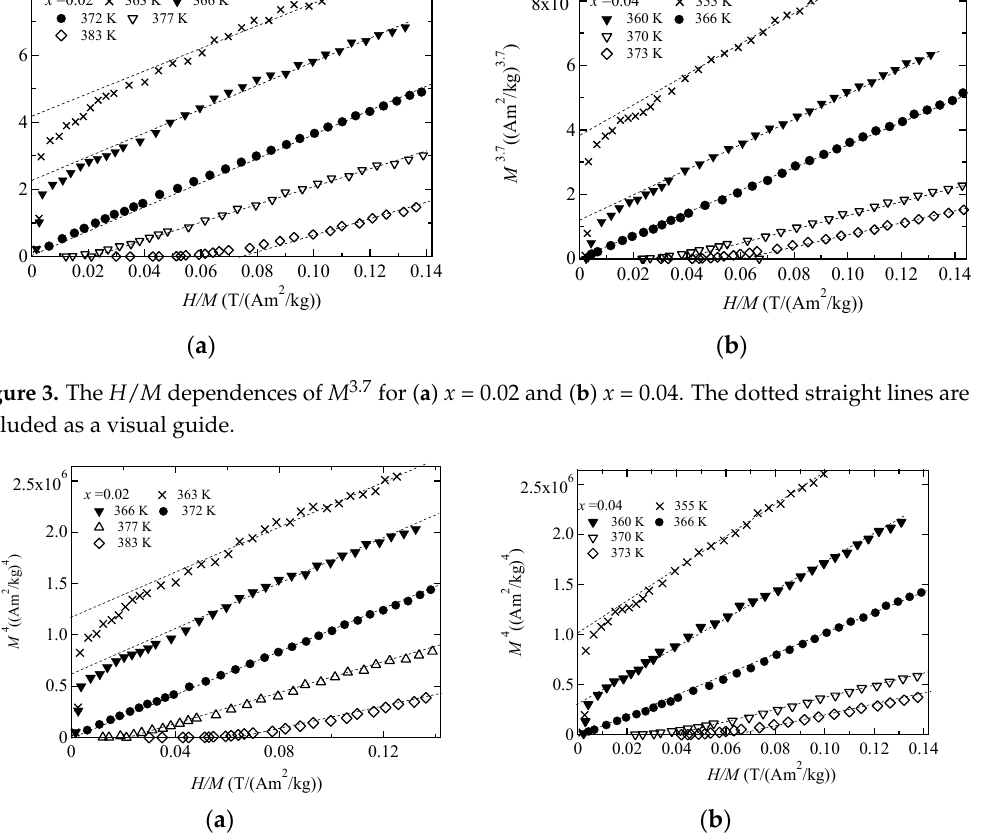
Figure 4. The H / M dependences of M 4 for ( a ) x = 0.02 and ( b ) x = 0.04. The dotted straight lines are included as a visual guide.